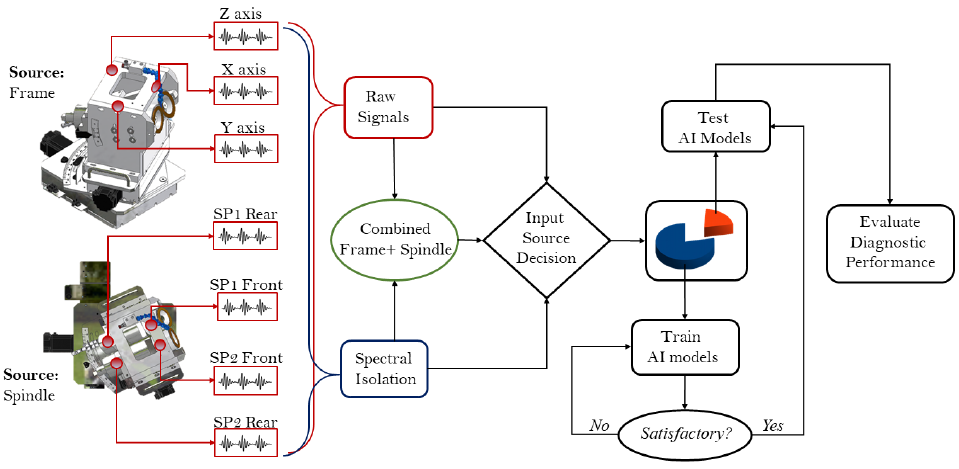
Figure 2. Proposed monitoring